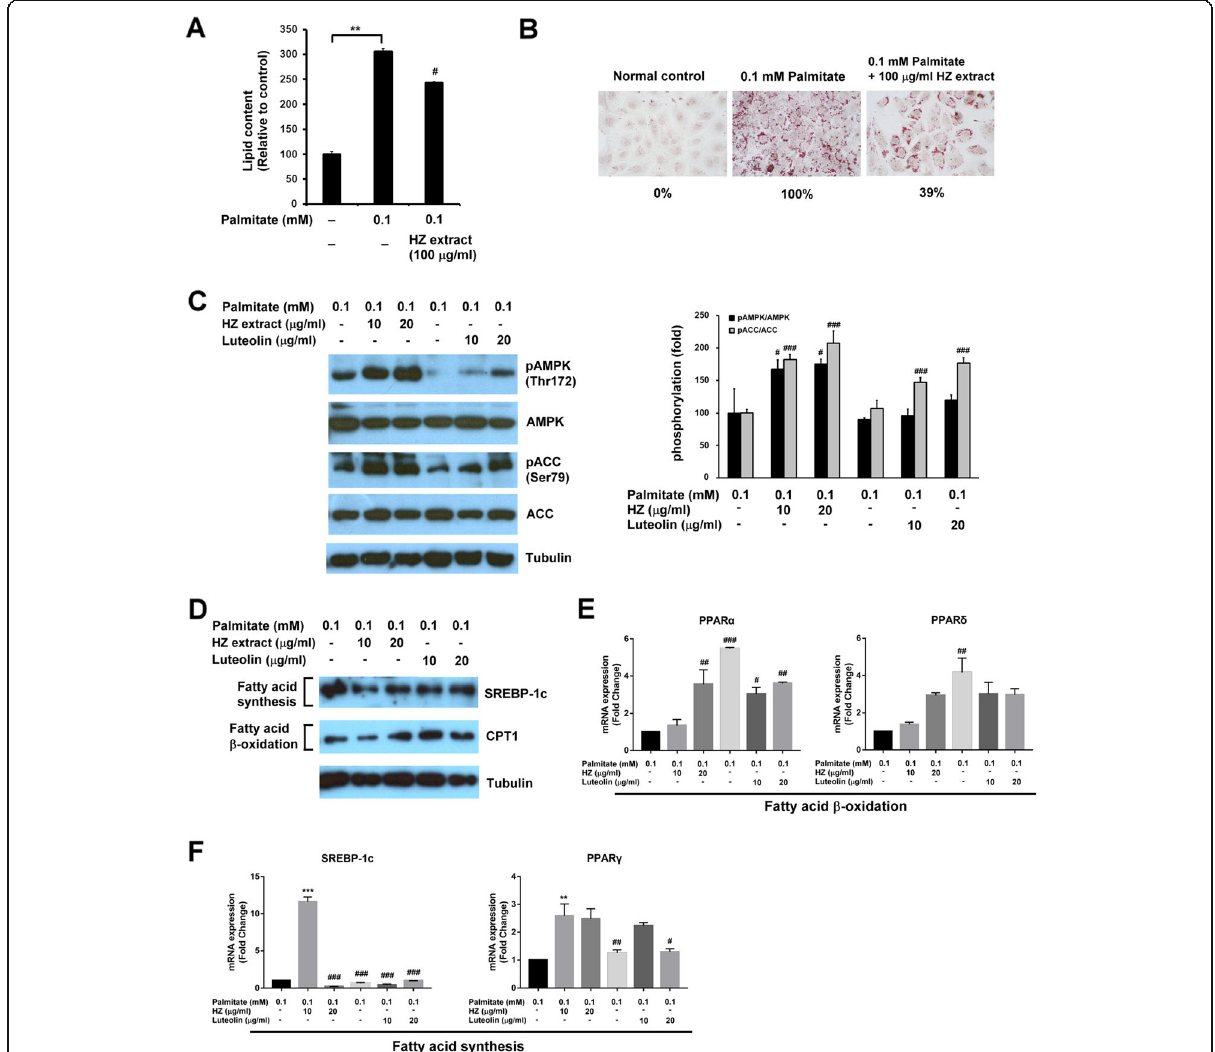
Fig. 2 Inhibition by HZ extract of palmitate-induced lipid accumulation in a human fatty liver cell model. a Quantitative analysis of lipid deposition in the Oil-Red O stained HuS-E/2 cells. b Images of the Oil-Red O stained HuS-E/2 cells were captured using a microscope at 400X original magnification. c Western blotting for phosphorylation of AMPK at Thr172 and ACC at Ser-79, total AMPK, ACC and tubulin. d Western blotting for SREBP-1c, CPT1, and tubulin. Tubulin served as a loading control. Quantitative analysis with Multi Gauge V3.0 is shown. e The levels of fatty acid β oxidation-related genes, PPAR α and PPAR δ . f The levels of fatty acid synthesis-related genes, SREBP-1c and PPAR γ . The data represent the mean ± SEM for three independent experiments. ND vs. palmitate: * p < 0.05; ** p < 0.01; *** p < 0.001. palmitate vs. HZ extract: # p < 0.05; ## p < 0.01; ### p <